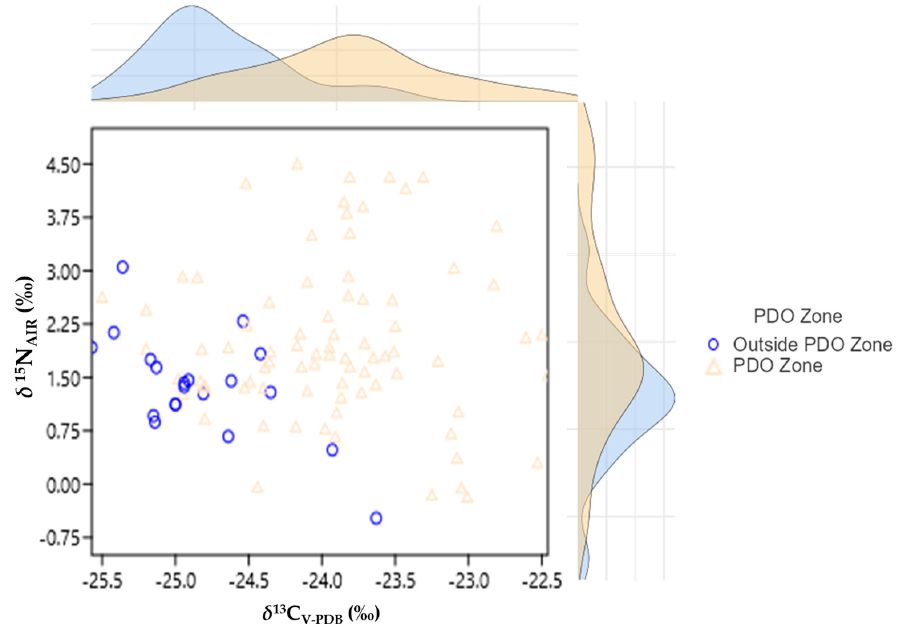
Figure 2. Results for the currant samples’ δ 15 N AIR (‰) and δ 13 C V-PDB (‰) values in a 2D scatterplot with densities.